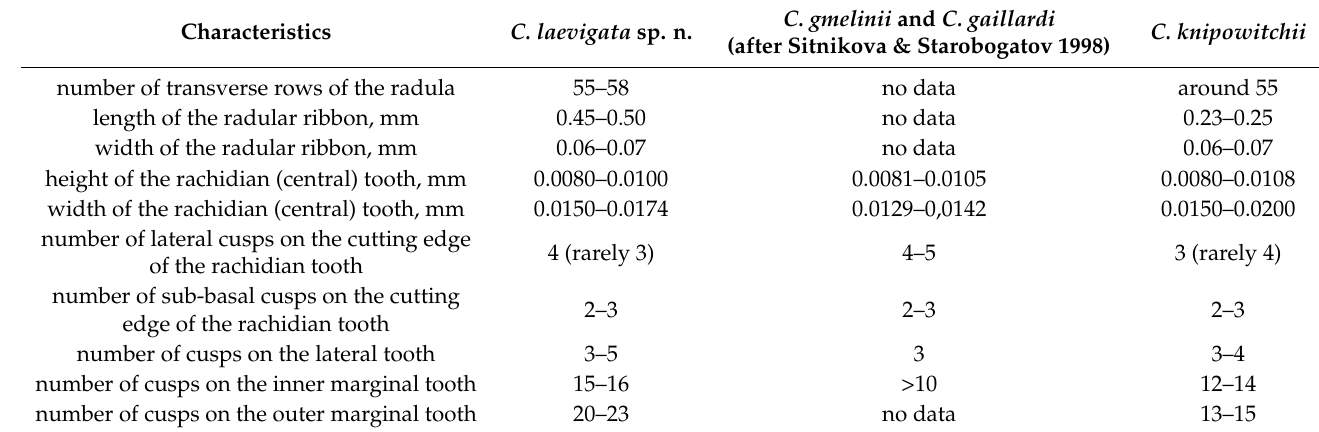
Table 6. Generalised data of the radular characteristics of Clathrocaspia species used in the present study.